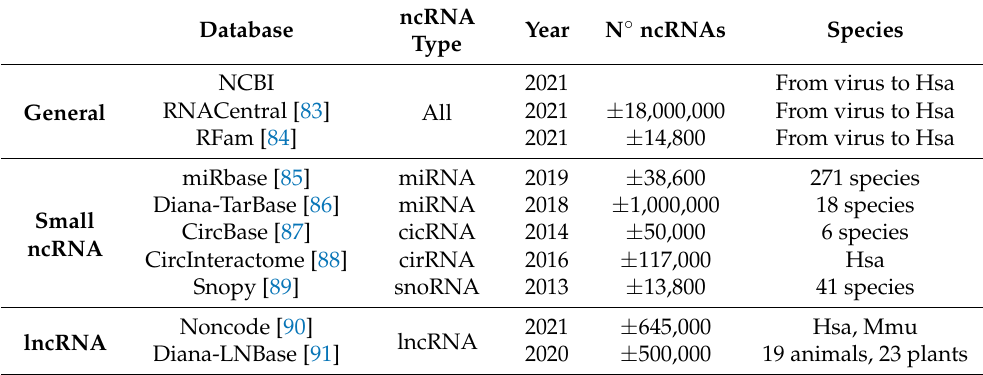
Table 3. Online databases containing information about